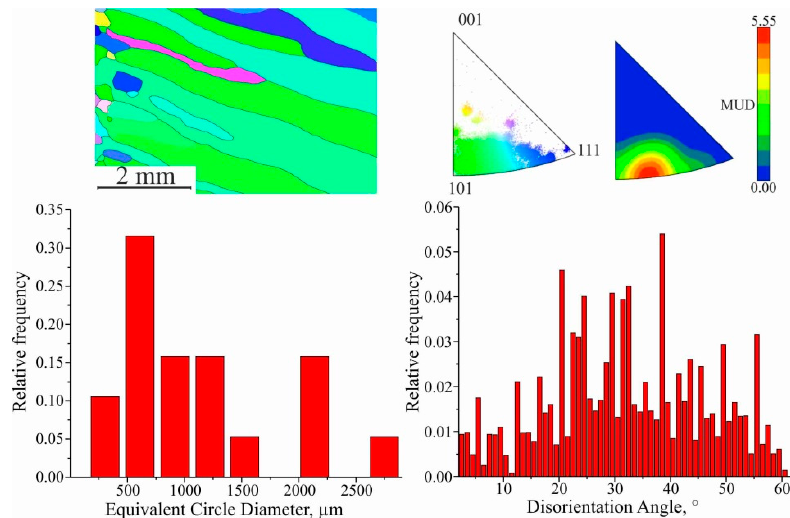
Figure 16. EBSD map fragment; grain size; disorientation; scattered and contoured IPFs for IV area.